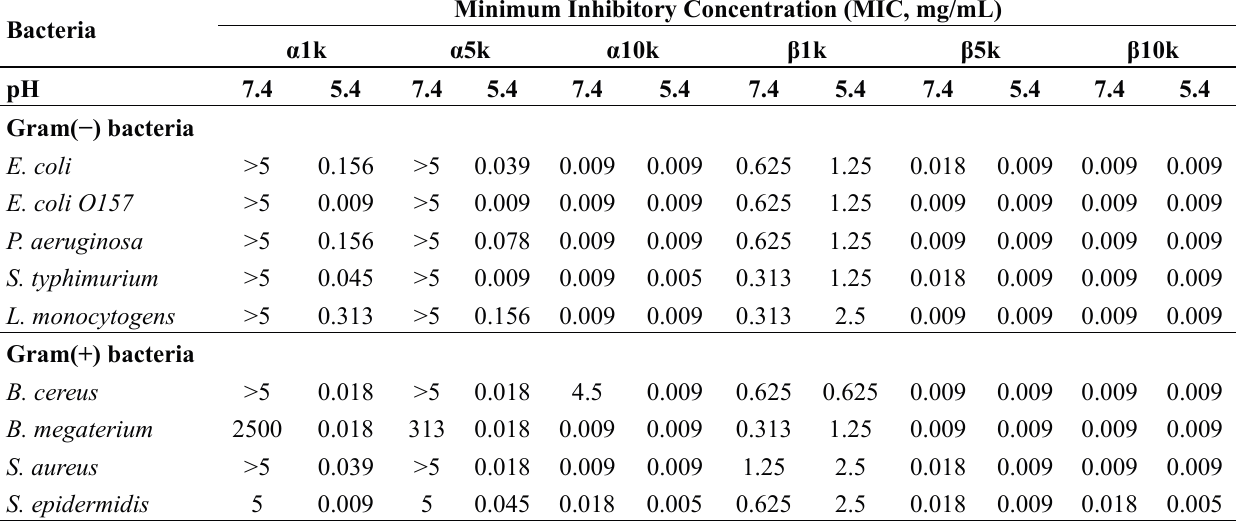
Table 1. Antibacterial activity of water-soluble α - and β -chitosan against drug-susceptible bacteria. Antimicrobial assays were performed in 10 mM sodium phosphate (pH 5.4